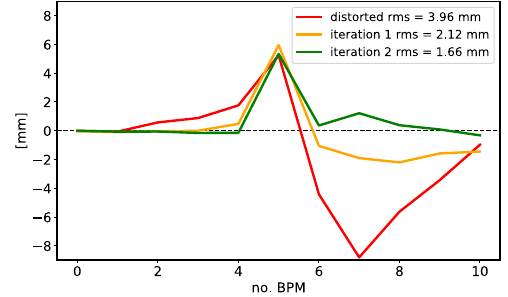
FIG. 4. Results of an SVD correction in the horizontal plane for the AWAKE electron line. The initial distorted trajectory was obtained with the reset() method of the OpenAI Gym environ- ment. It took 2 iterations to correct below 2 mm RMS, which is the target cumulative reward of the Gym environment. It cannot correct for BPM 5, as it is at a location of peak dispersion. Its reading depends on the energy distribution coming out of the source, which can vary from day to day. Also, the RL algorithms cannot correct for it if it has only dipole correctors as actions. The target cumulative reward defined for the AWAKE OpenAI Gym environment needs to take this into account.